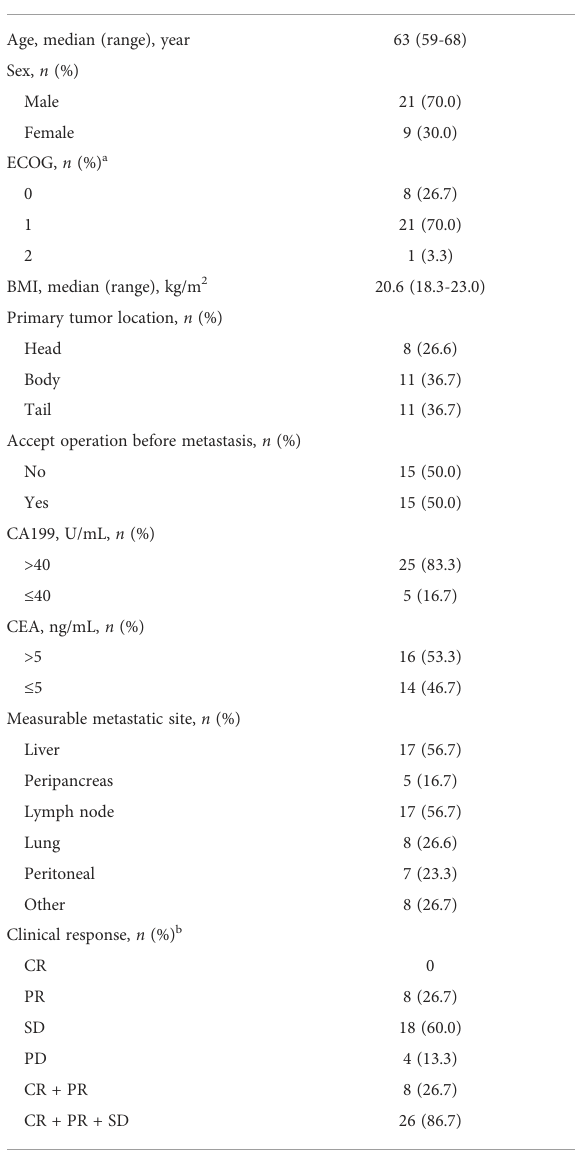
TABLE 2 Baseline characteristics of the